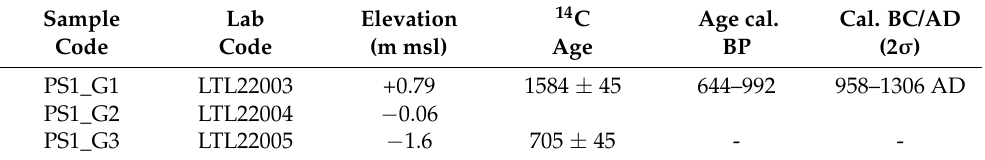
Table 1. Radiocarbon ages for dated samples from Psatha